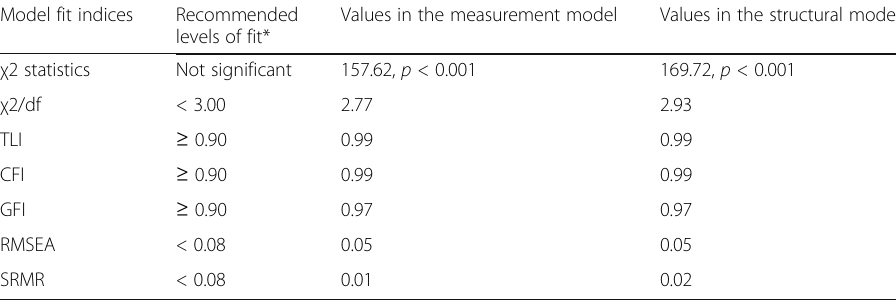
Table 4 Fit indices for the measurement and structural model